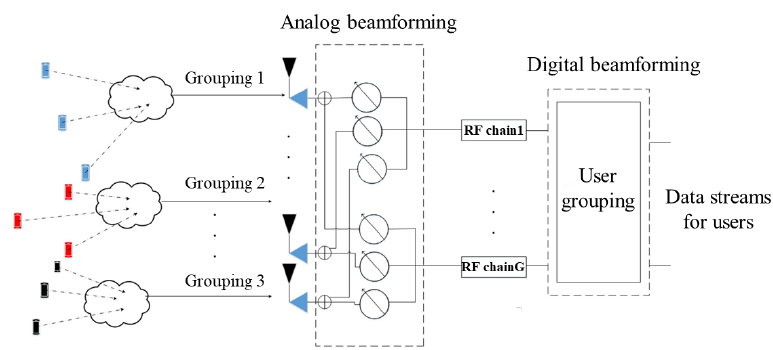
Figure 1. System model of uplink mmWave-MIMO-NOMA